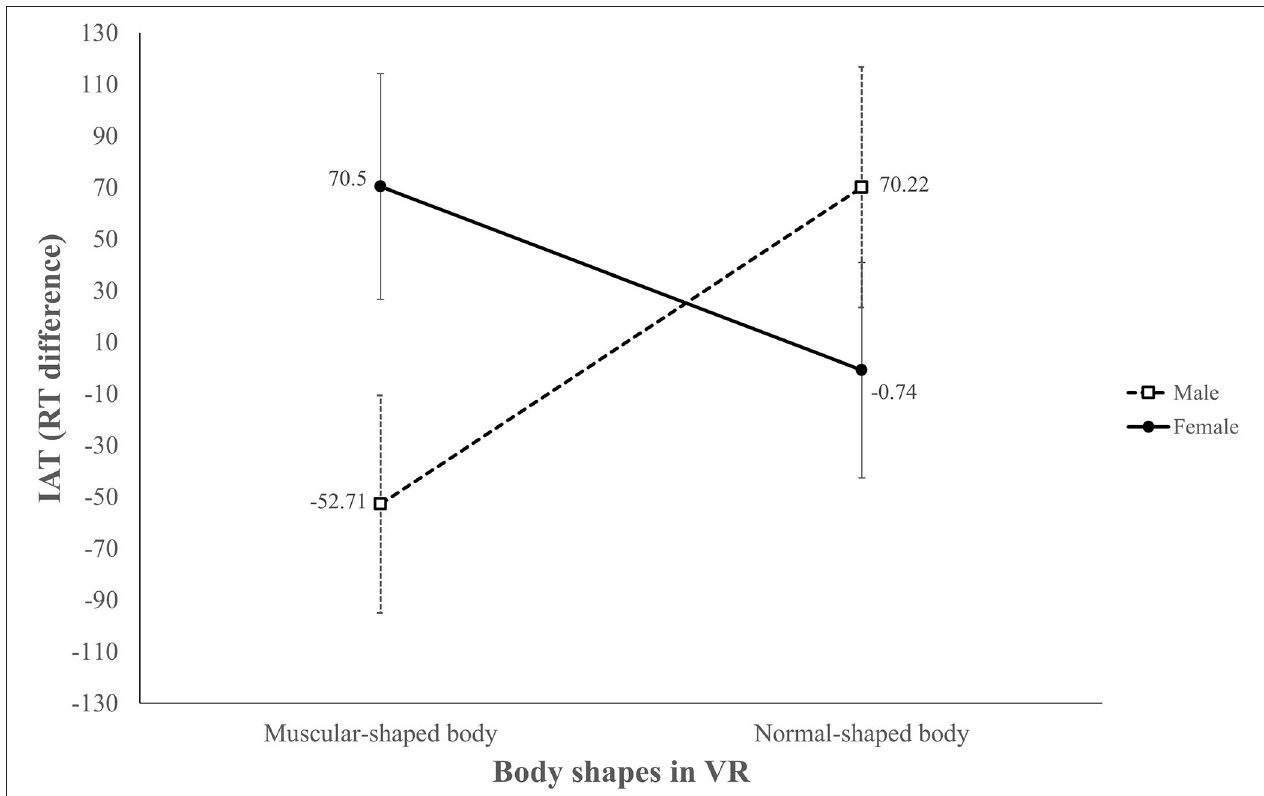
FIGURE 7 | Interaction between avatar body shape and sex of participants in predicting participants’ self-concept after the VR experience.